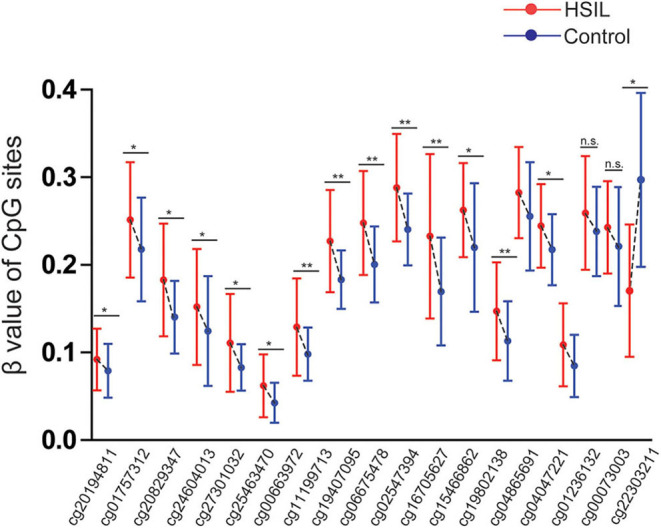
Significant differences in 19 CpG sites of SOX1 between HSIL and controls in TCGA and GEO dataset. P-value were calculated by the Mann–Whitney U-test. *P < 0.05, **P < 0.001. If P > 0.05, there is no significance.